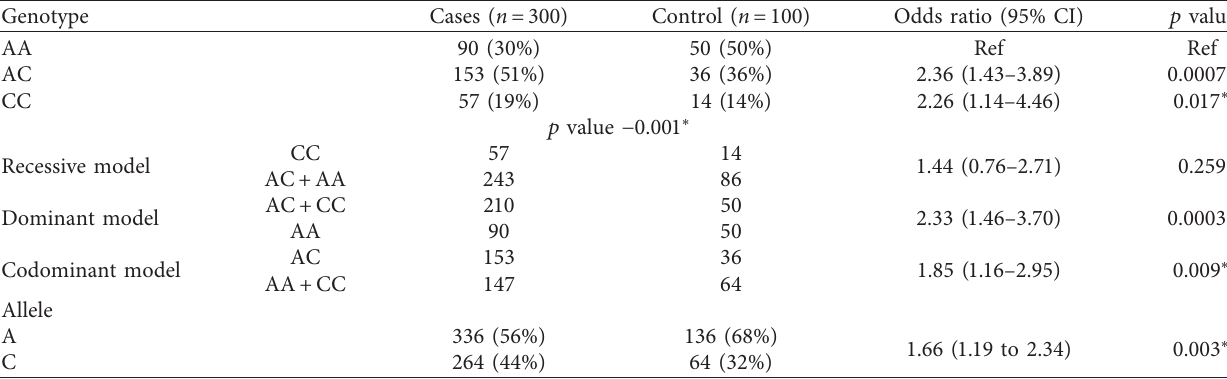
Table 3: Genotypic and allelic distribution and association analysis of KCNQ1 rs2237895 genes polymorphism and risk of T2DM under different genetic models.